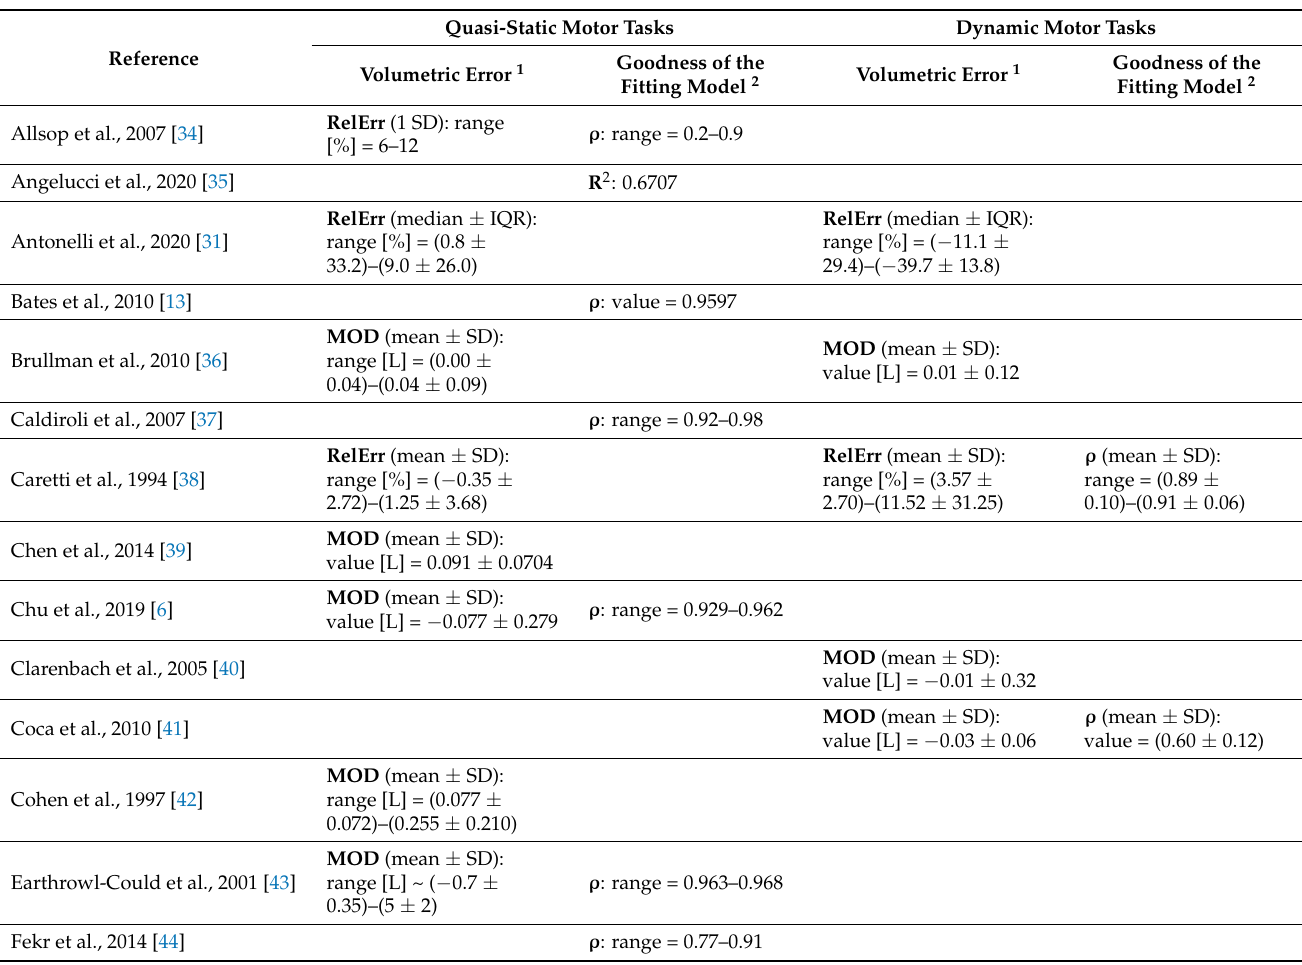
Table 4. Assessment of the